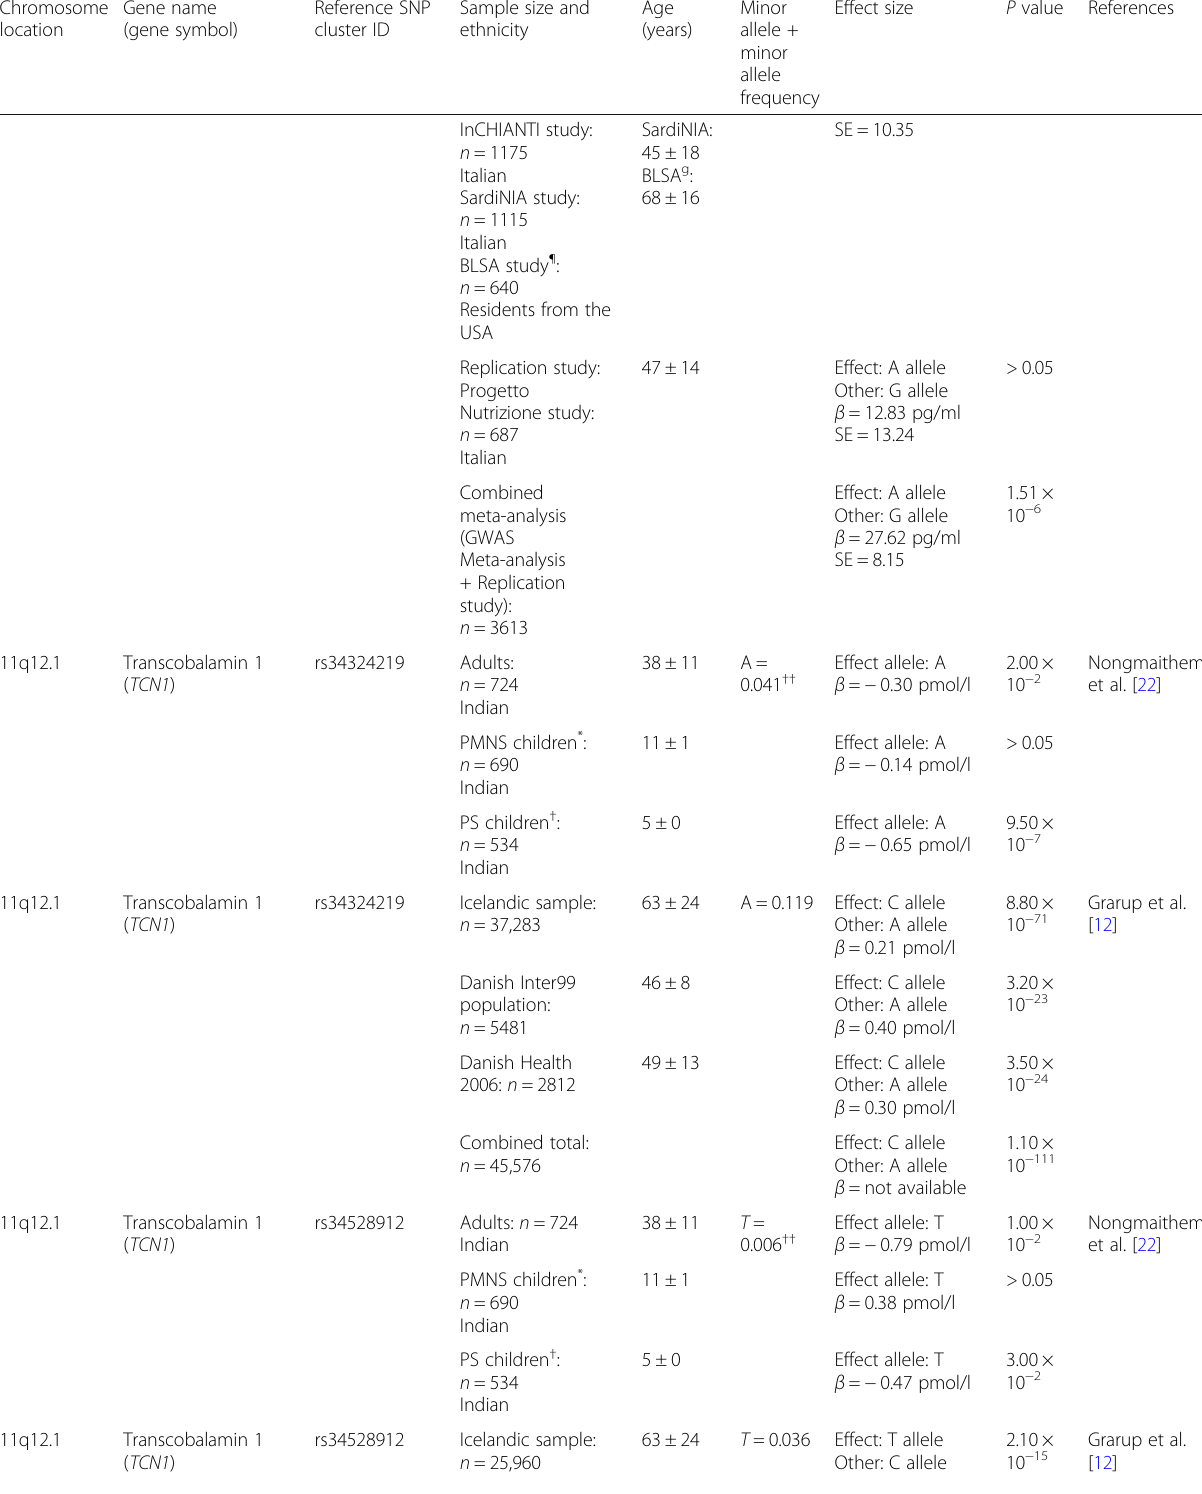
Table 1 Genome-wide association studies showing the association of SNPs with vitamin B12 concentrations. Genome-wide association studies testing the association between SNPs and vitamin B12 concentrations. The chromosome location, gene name, reference SNP cluster ID, sample size and ethnicity, mean age, observed frequency of the minor allele in the population, effect size and P value are shown in the table. The order of SNPs reflects the order of the chromosome location